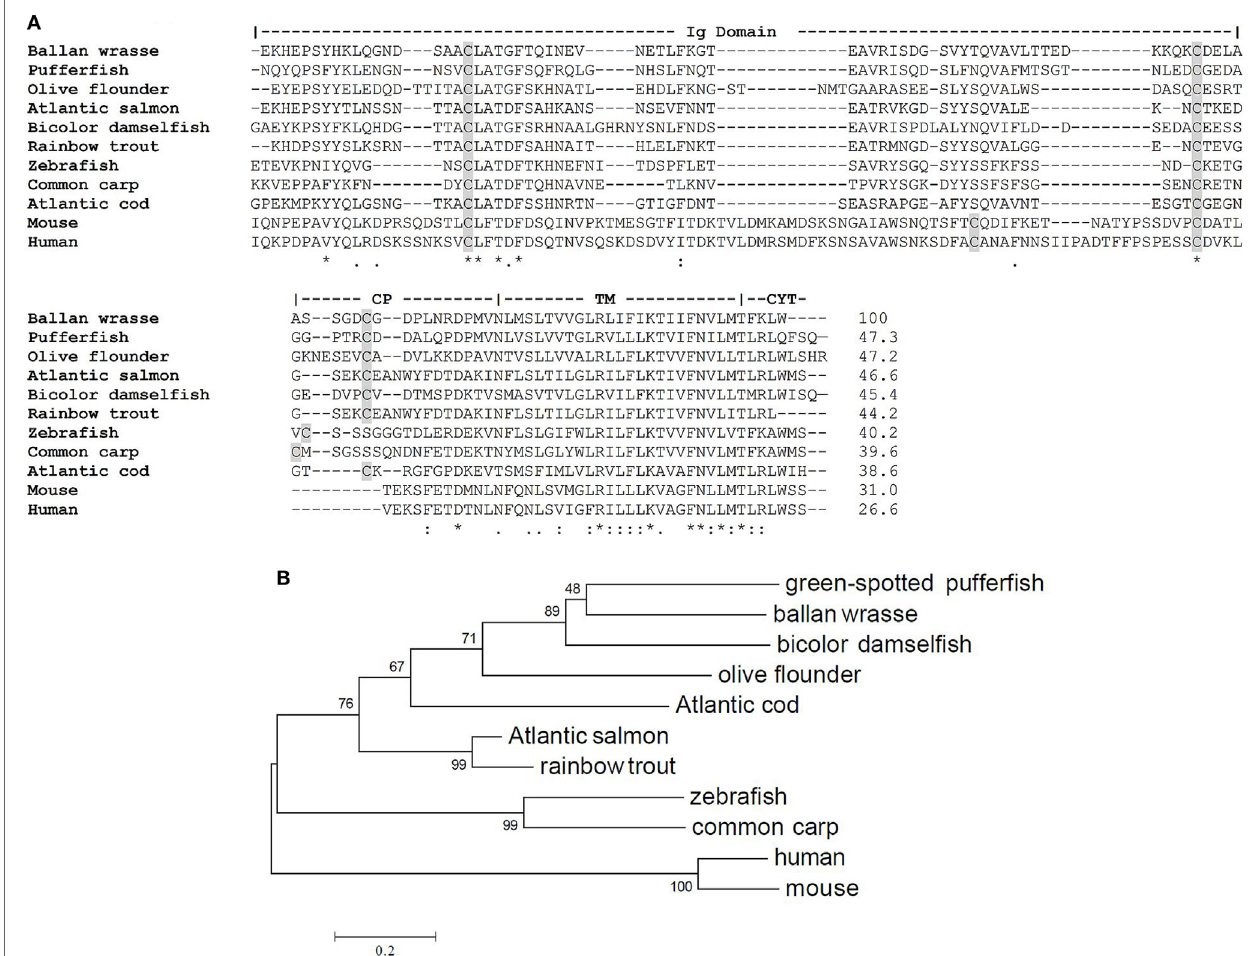
FigUre 3 | Similarity between T cell receptor (TCR) C α of Ballan wrasse and other species. (a) Alignment of TCR C α sequences from Ballan wrasse (allotype A) and other species. Cysteines are shaded in gray. (B) Phylogenetic tree of Ballan wrasse TCR C α and other species. The unrooted tree was constructed by the neighbor joining method with 1,000 bootstrap replicates using MEGA6 software. The accession numbers are as follows: Green-spotted pufferfish (CAC86243.1), bicolor damselfish (AAO88997.1), olive flounder (BAC65457.1), Atlantic salmon (AAS79492.1), rainbow trout (AAR19288.1), Atlantic cod (CAD28810.1), common carp (BAD89003.1), zebrafish (AAL29402.1), mouse (X14387.1), and human